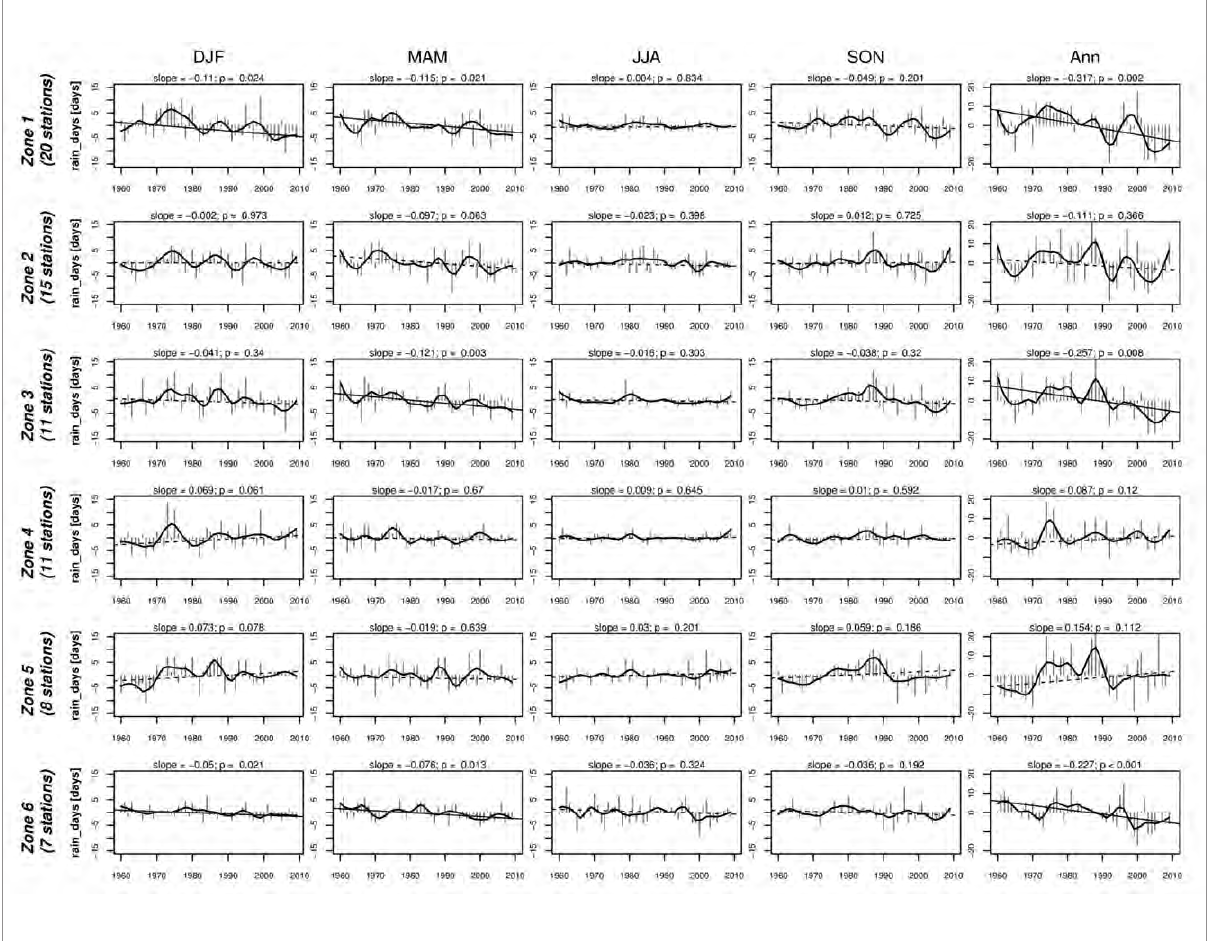
Figure 6: Regional mean time series and trends in number of rain days (days) for stations in the six water management zones for summer (DJF), autumn (MAM), winter (JJA), spring (SON) and annual (Ann) means. Grey bars represent departures from the 1960–2010 mean for each year. Black curves are a Loess smoothing of the yearly data with a bandwidth of 0.25. Trend lines are shown for the Sen’s slope estimate. Solid trend lines indicate the trend is significant at the 5% level and dashed lines are not significant at this